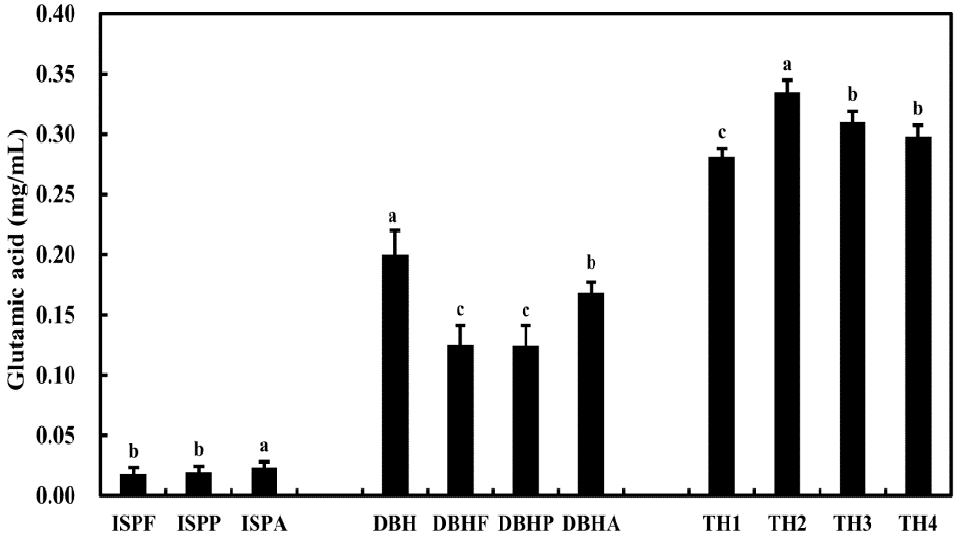
Figure 1. Glutamic acid content of jeotgal alternative materials after the enzymatic digestion process. Isolated soybean protein (ISP), dry-aged beef (DB), and tomato (T). Data are expressed as means ± SD. Different lowercase letters indicate a significant difference in the same jeotgal alternative ( p <